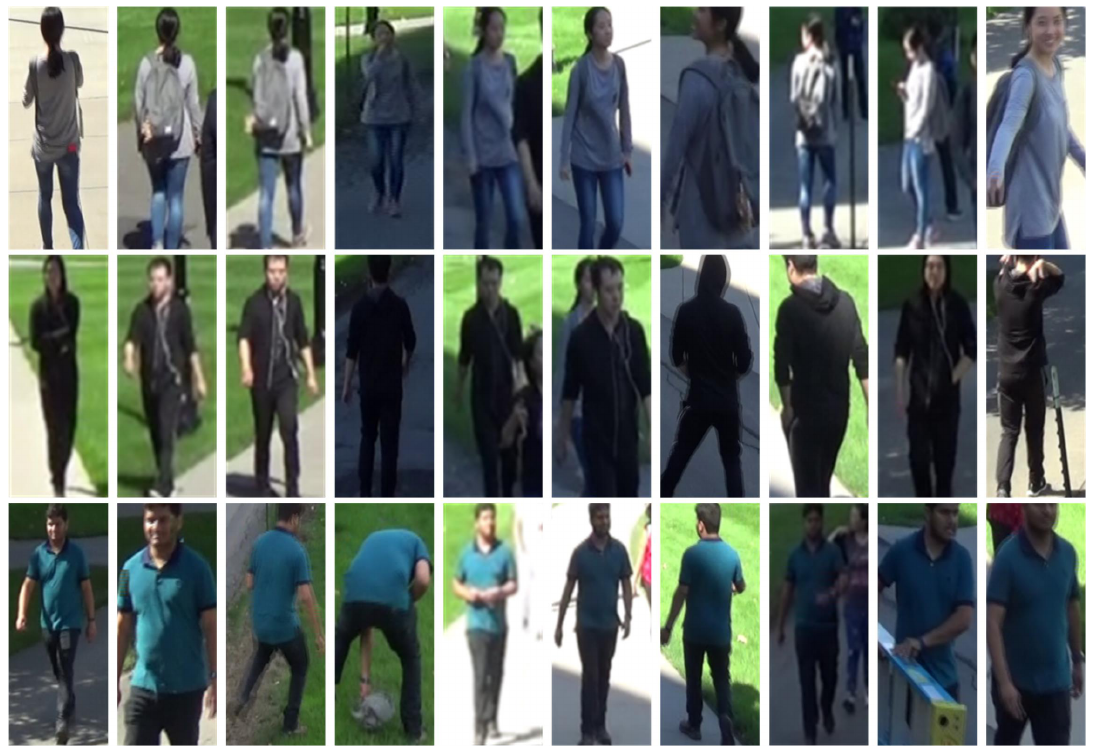
Figure 8. Examples extracted from RPIField Database [18]. There are three subjects which are captured from different views, by different cameras—Subjects with IDs 1, 6, and 20, respectively.